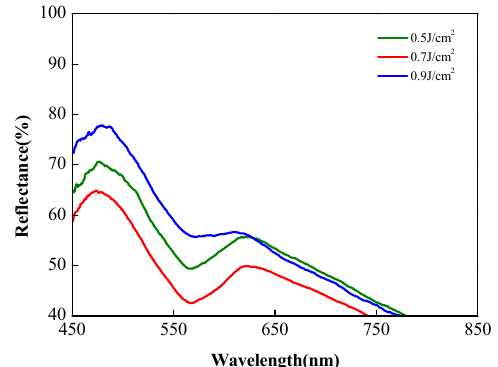
Figure 4. Reflectance spectra of in vivo rat skin with combined treatment after different laser irradiation doses at 60 min.